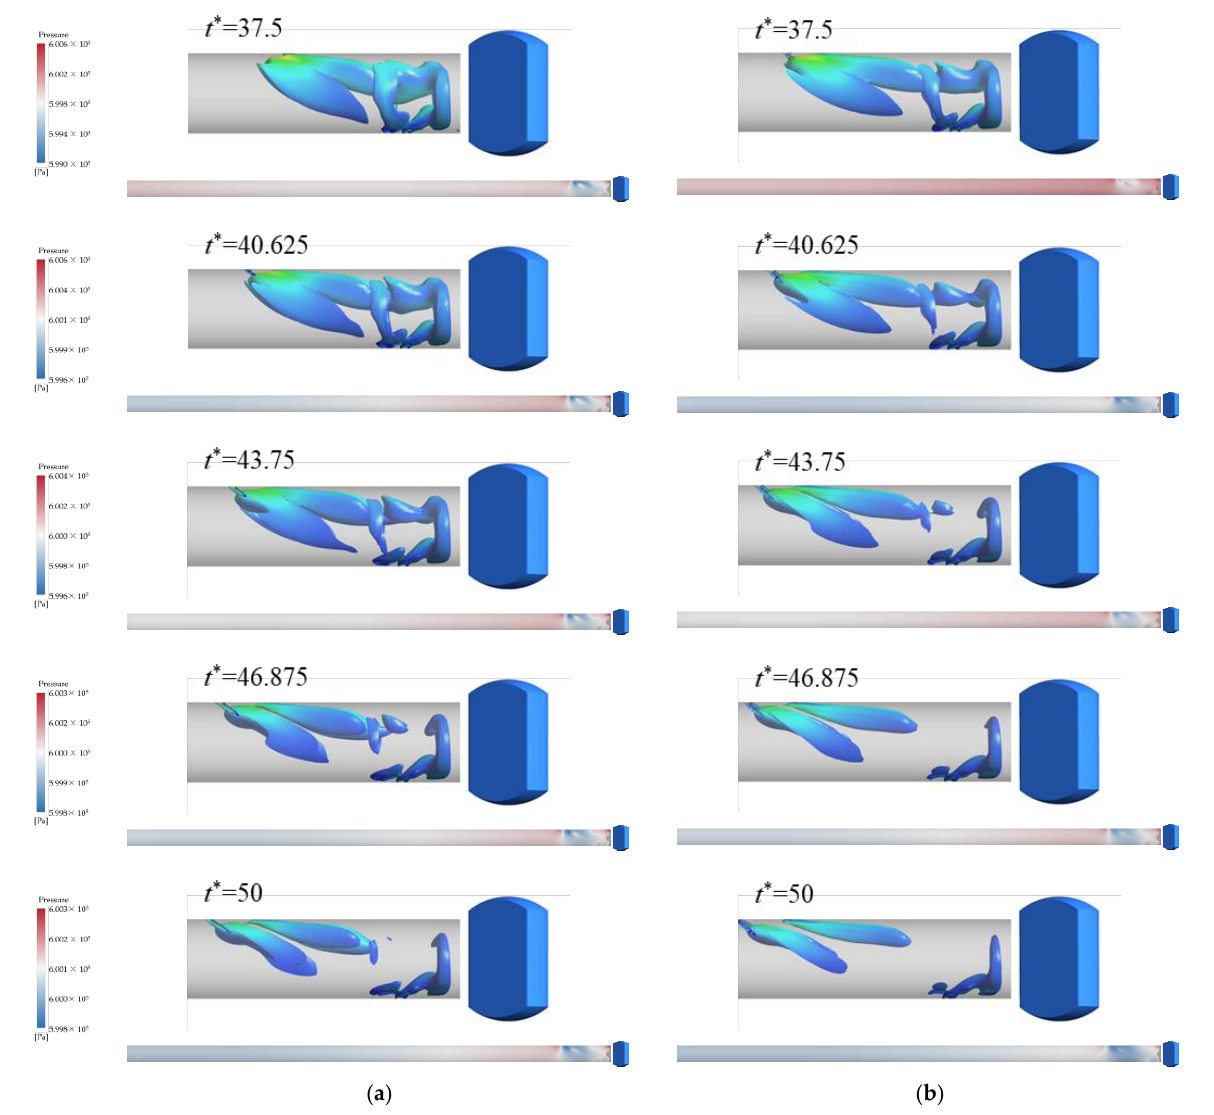
Figure 12. The vortex structure distribution of the inlet flow channel based on the Q criterion of Q = 10 s −2 and the distribution of inlet channel pressure: ( a ) closing law I. ( b ) closing law V ′ .